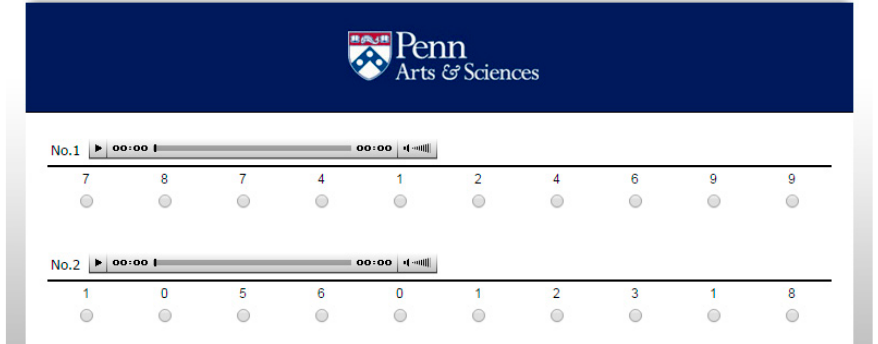
Figure 8. Screenshot of a part of the survey in Qualtrics.